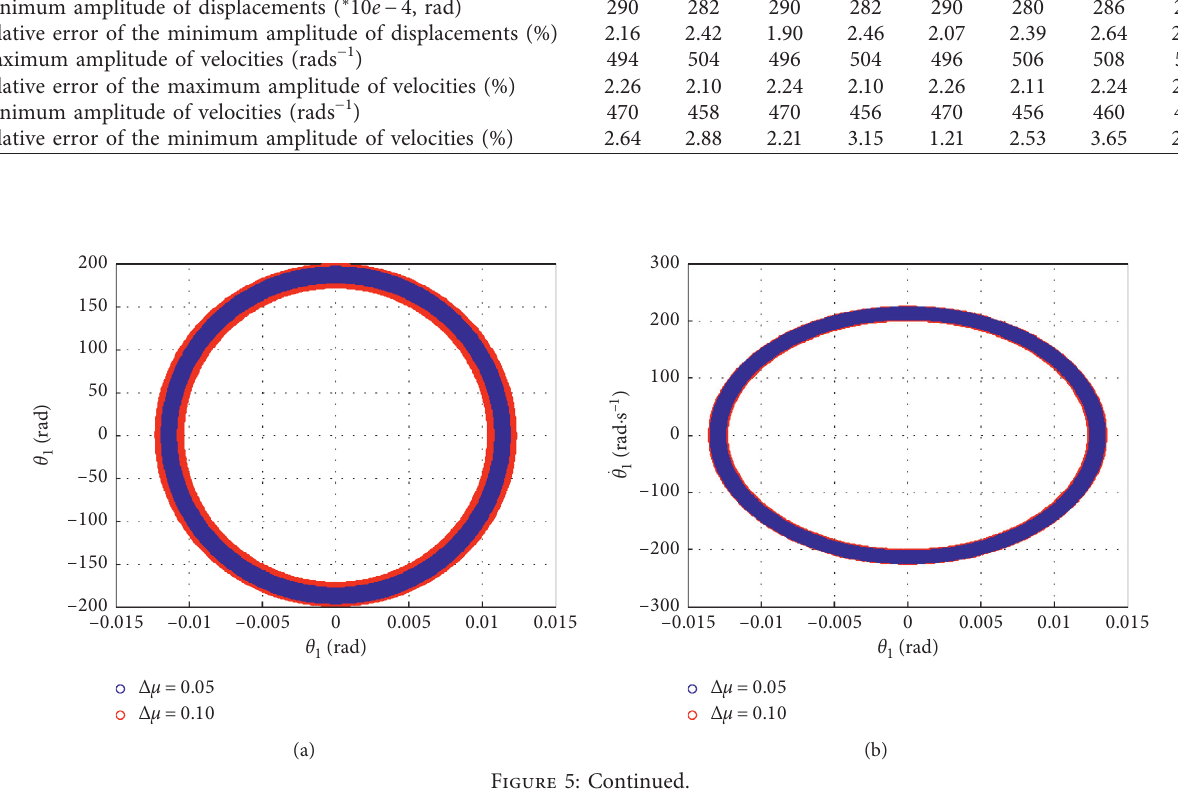
� 0 . 01; μm � 0.25; 0.35; 0.50). m,i